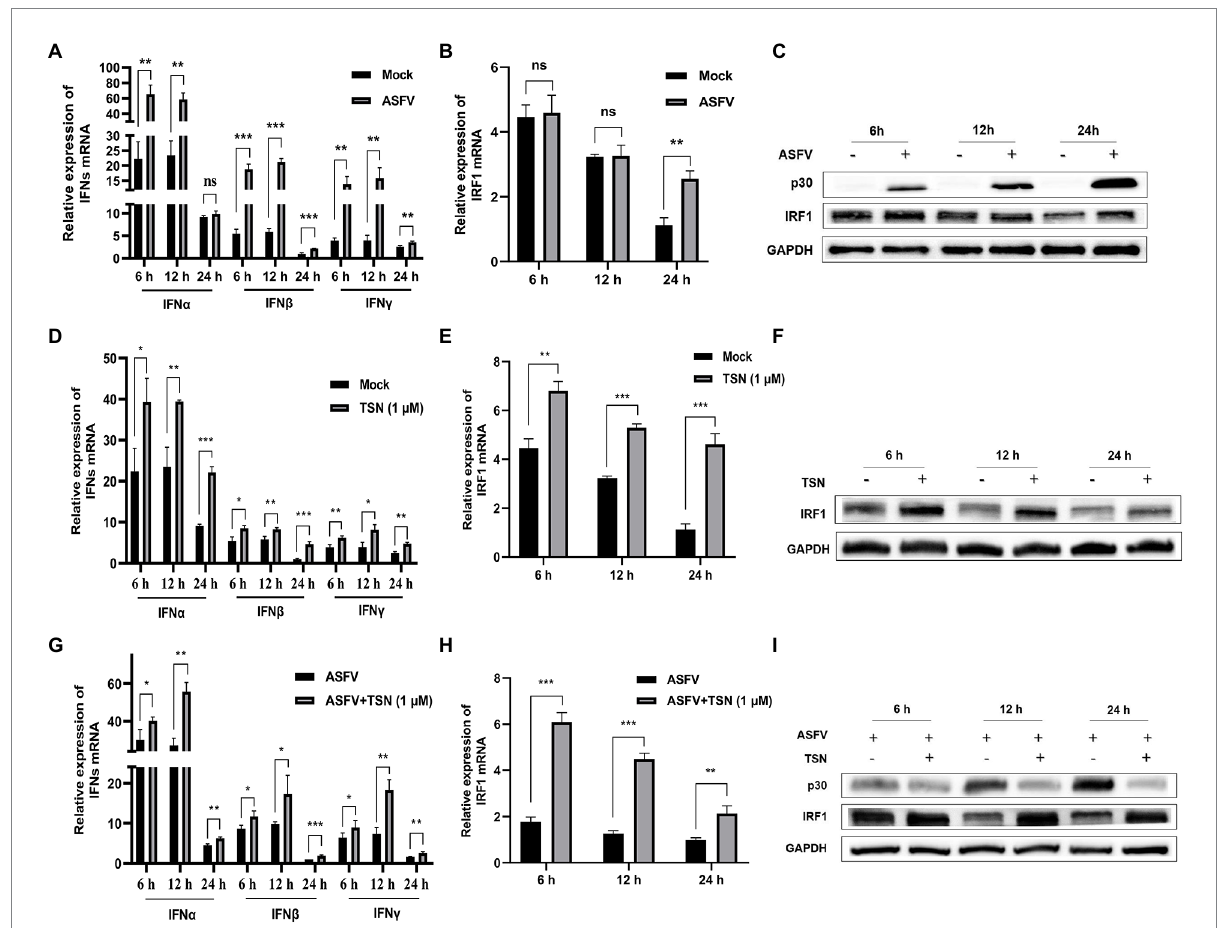
FIGURE 10 TSN treatment upregulates the mRNA expressions of IFNs and IRF1, and the protein expression of IRF1 in PAMs. 0.014 MOI ASFV infected the PAMs for 6, 12, and 24 h to test its effect on the expression level of IFNs (IFN α , IFN β and IFN γ ) and IRF1. Besides, 1 μ M TSN was added to PAMs with or without ASFV infection (0.014 MOI) for 6, 12, and 24 h to test its effect on the expression levels of IFNs (IFN α , IFN β and IFN γ ) and IRF1. The vertical axis shows the relative expression level (fold-change) of IFNs or IRF1 mRNA. The fold-changes were calculated by the 2 ∆∆CT method and normalized by IFN β or IRF1 levels at 24 h in mock or ASFV group. (A) The mRNA levels of IFN α , IFN β and IFN γ in PAMs with ASFV infection at 6, 12, and 24 h was analyzed using RT-qPCR. (B) The mRNA level of IRF1 in PAMs with ASFV infection at 6, 12, and 24 h was analyzed using RT-qPCR. (C) The protein level of IRF1 in PAMs with ASFV infection at 6, 12, and 24 h was analyzed using Western Blot. (D) The mRNA levels of IFN α , IFN β and IFN γ in PAMs with or without TSN treatment at 6, 12, and 24 h was analyzed using RT-qPCR. (E) The mRNA level of IRF1 in PAMs with or without TSN treatment at 6, 12, and 24 h was analyzed using RT- qPCR. (F) The protein level of IRF1 in PAMs with or without TSN treatment at 6, 12, and 24 h was analyzed using Western Blot. (G) The mRNA levels of IFN α , IFN β and IFN γ in ASFV-infected PAMs with or without TSN treatment at 6, 12, and 24 h was analyzed using RT-qPCR. (H) The mRNA level of IRF1 in ASFV-infected PAMs with or without TSN treatment at 6, 12, and 24 h was analyzed using RT-qPCR. (I) The protein level of IRF1 in ASFV-infected PAMs with or without TSN treatment at 6, 12, and 24 h was analyzed using Western Blot. *** denotes p < 0.001; ** denotes p < 0.01; * denotes p < 0.05; ns denotes not